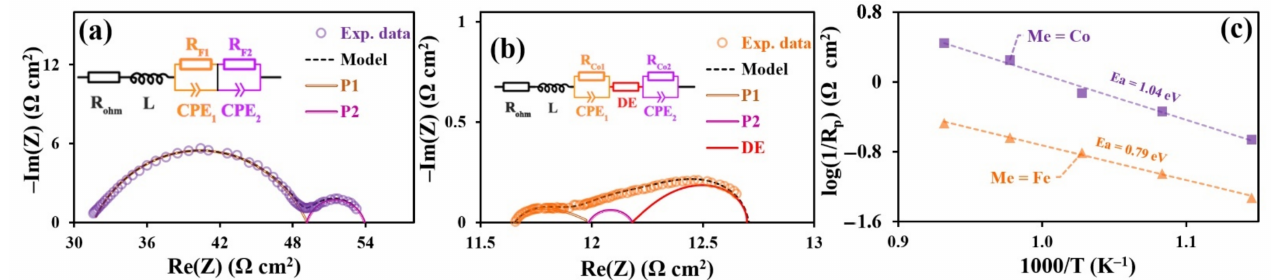
Figure 8. Fitting impedance data of symmetry cells with the PrNi 0.4 Fe 0.6 O 3- δ and PrNi 0.4 Co 0.6 O 3- δ electrodes: used models for fitting impedance data of cells with Fe ( a ) and Co-contended ( b ) air electrodes and temperature dependencies of polarization resistance these cells ( c ).